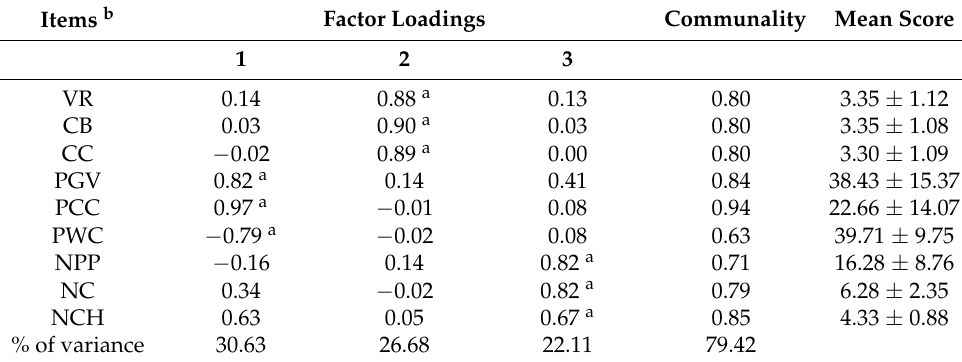
Table 2. Principal component factor analysis of the visual attributes of flower borders in urban green space.